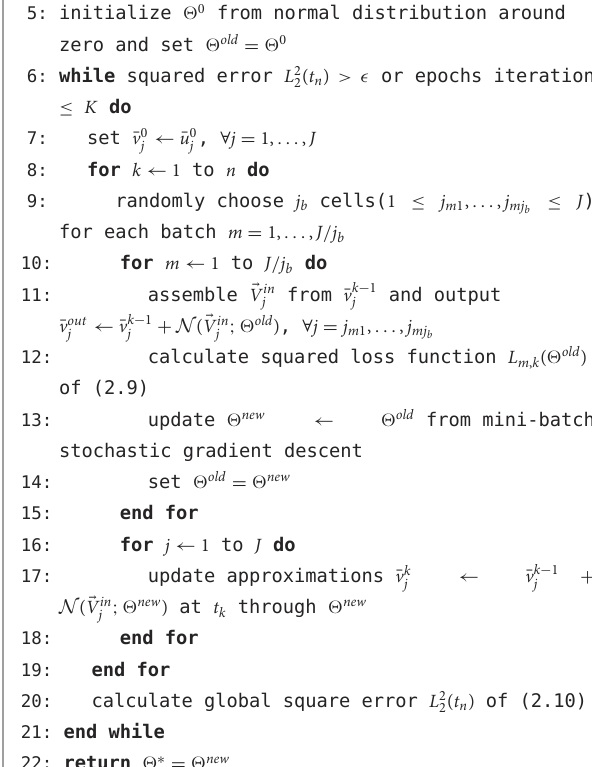
Algorithm 1. Training of the network parameter 2 ∗ for the CANN method.